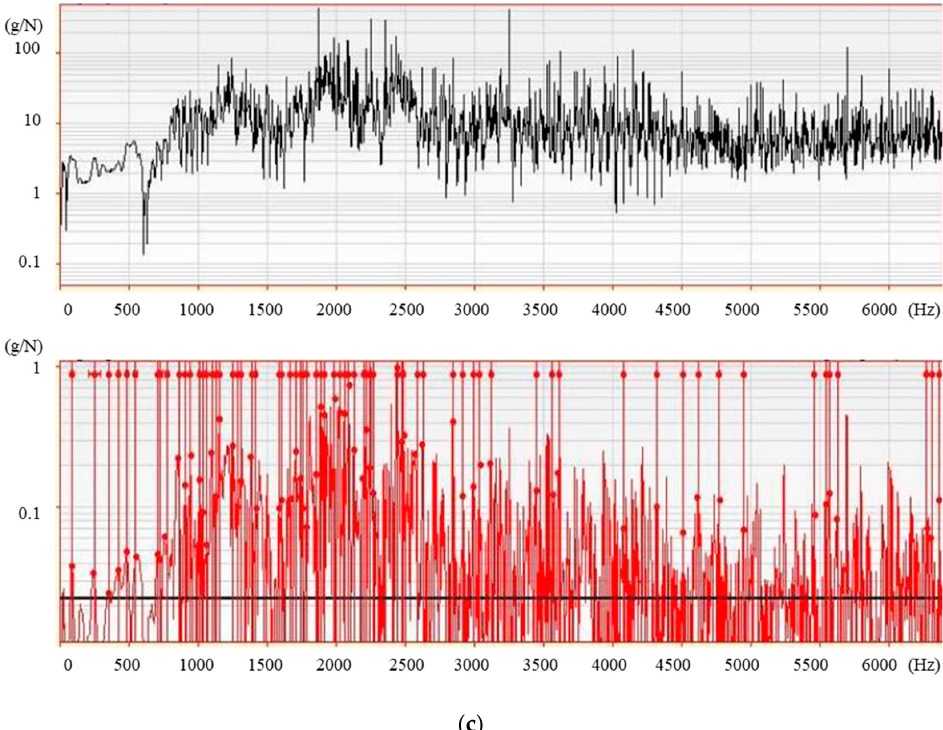
Figure A1. The frequency responses of the intersection of the main branch and primary branch ( a ), the intersection of the primary branch and secondary branch ( b ), and the intersection of the secondary branch and fruiting branch ( c ).